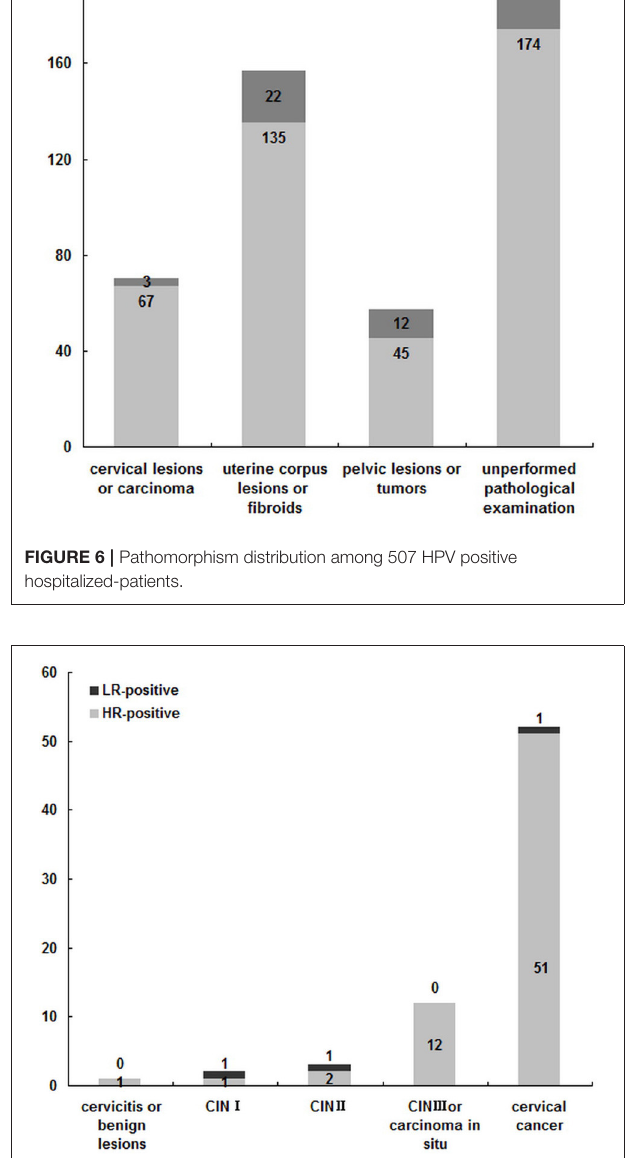
was one patient with HPV6 single infection among cervical carcinoma patients. Among the above patients, the HPV16 ratio- in-positive (61.54%) was comparable to that in Beijing from 2014 to 2015 (58.54%) (24) and was obviously more than that among esophageal carcinoma samples (45.24%) (40). Moreover,